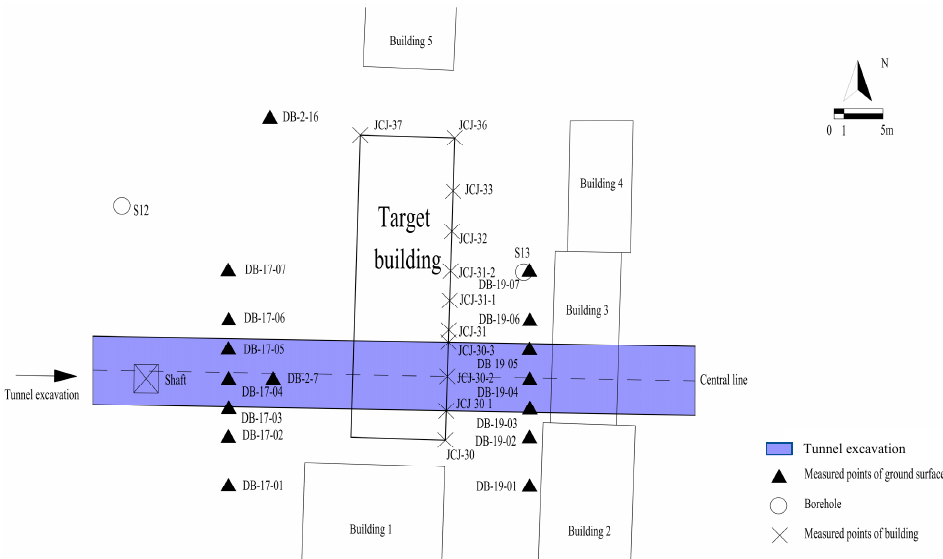
Figure 7. Distribution of the building and the measured points .